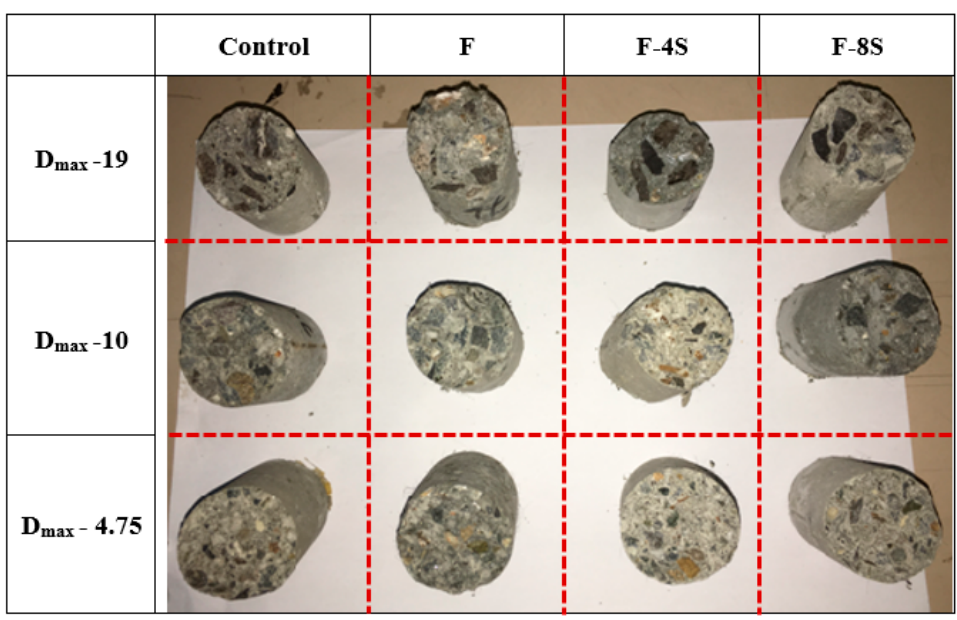
Figure 12. Failed samples of the Charpy impact test (sample size = 40 ϕ × 100 mm).